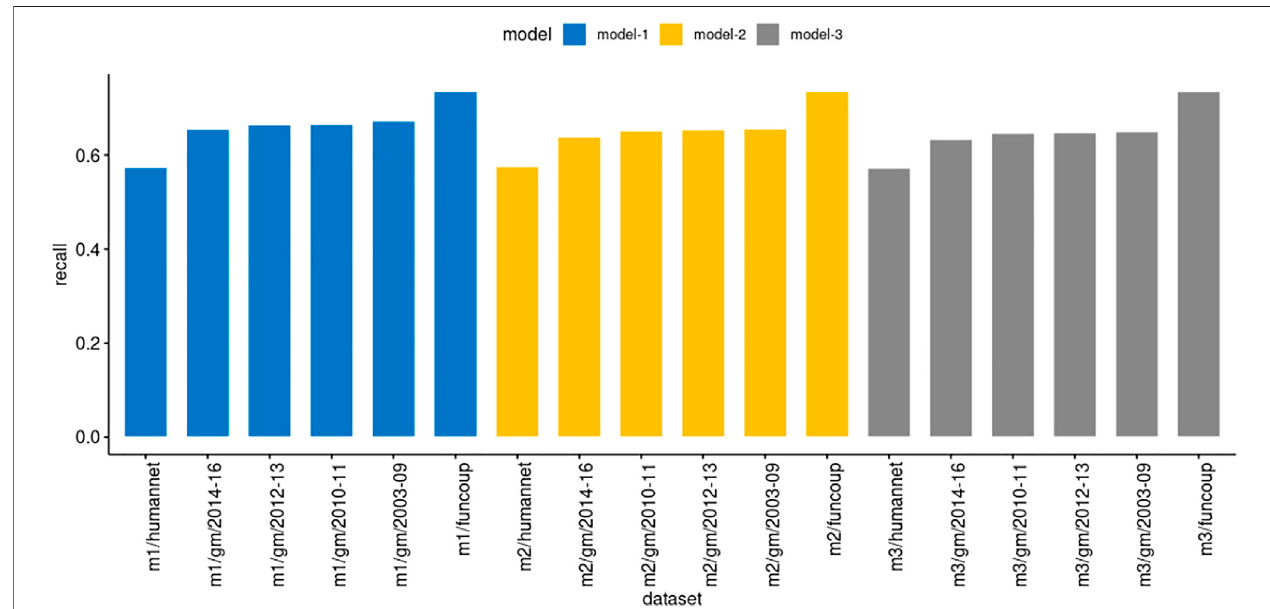
FIGURE 3 | Comparison of recall in the models derived from DS4 (model3/m3), DS5 (model2/m2) and DS6 (model1/m1) trained by PredPrIn. The genemania datasets are organized in the following year intervals: 2003 – 2009 (51 datasets), 2010 – 2011 (46 datasets), 2012 – 2013 (44 datasets) and 2014 – 2016 (53 datasets). The standarddeviationsforthesameintervals,respectively,formodel1were0.106,0.145,0.116,and0.125,formodeltwowere0.107,0.148,0.108,and0.121, fi nally,for model 3 were 0.109, 0.151, 0.104, and 0.122.